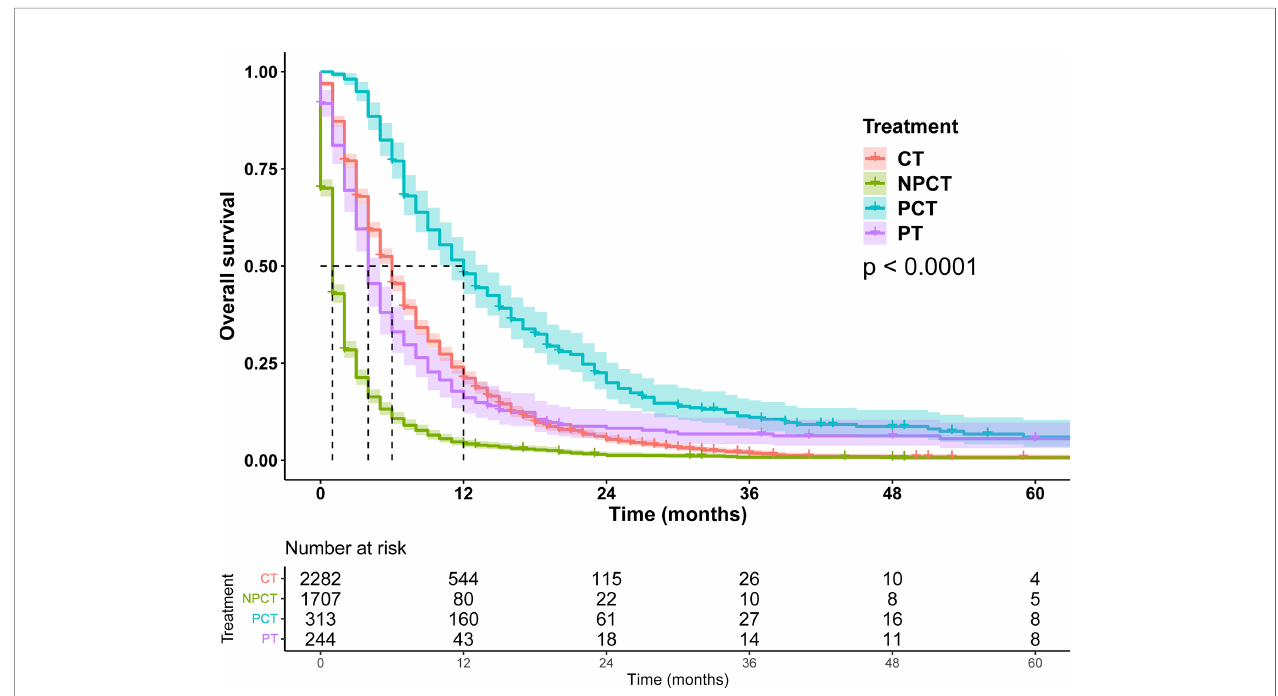
FIGURE 2 | Survival curves for patients with metastatic pancreatic cancer in different treatment